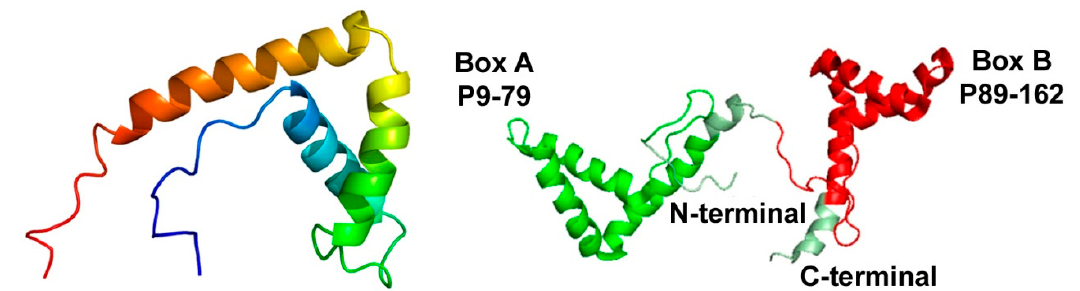
Figure 3. Structure of high-mobility group box 1 (HMGB1) protein. HMGB1 is a protein consisting of 216 residues, 30 kD, highly conserved among mammals. The protein contains three alpha-helices, connected together by loops. It consists of two homologous DNA-binding domains of the HMG-box type: Box A (and Box B) and segment C-terminal, a negatively charged “tail”. There are two nuclear localization sequences. Green marks the linker and terminal regions of HMGB1. Box A (P9–79) is colored in green and Box B (P89–162) in red.